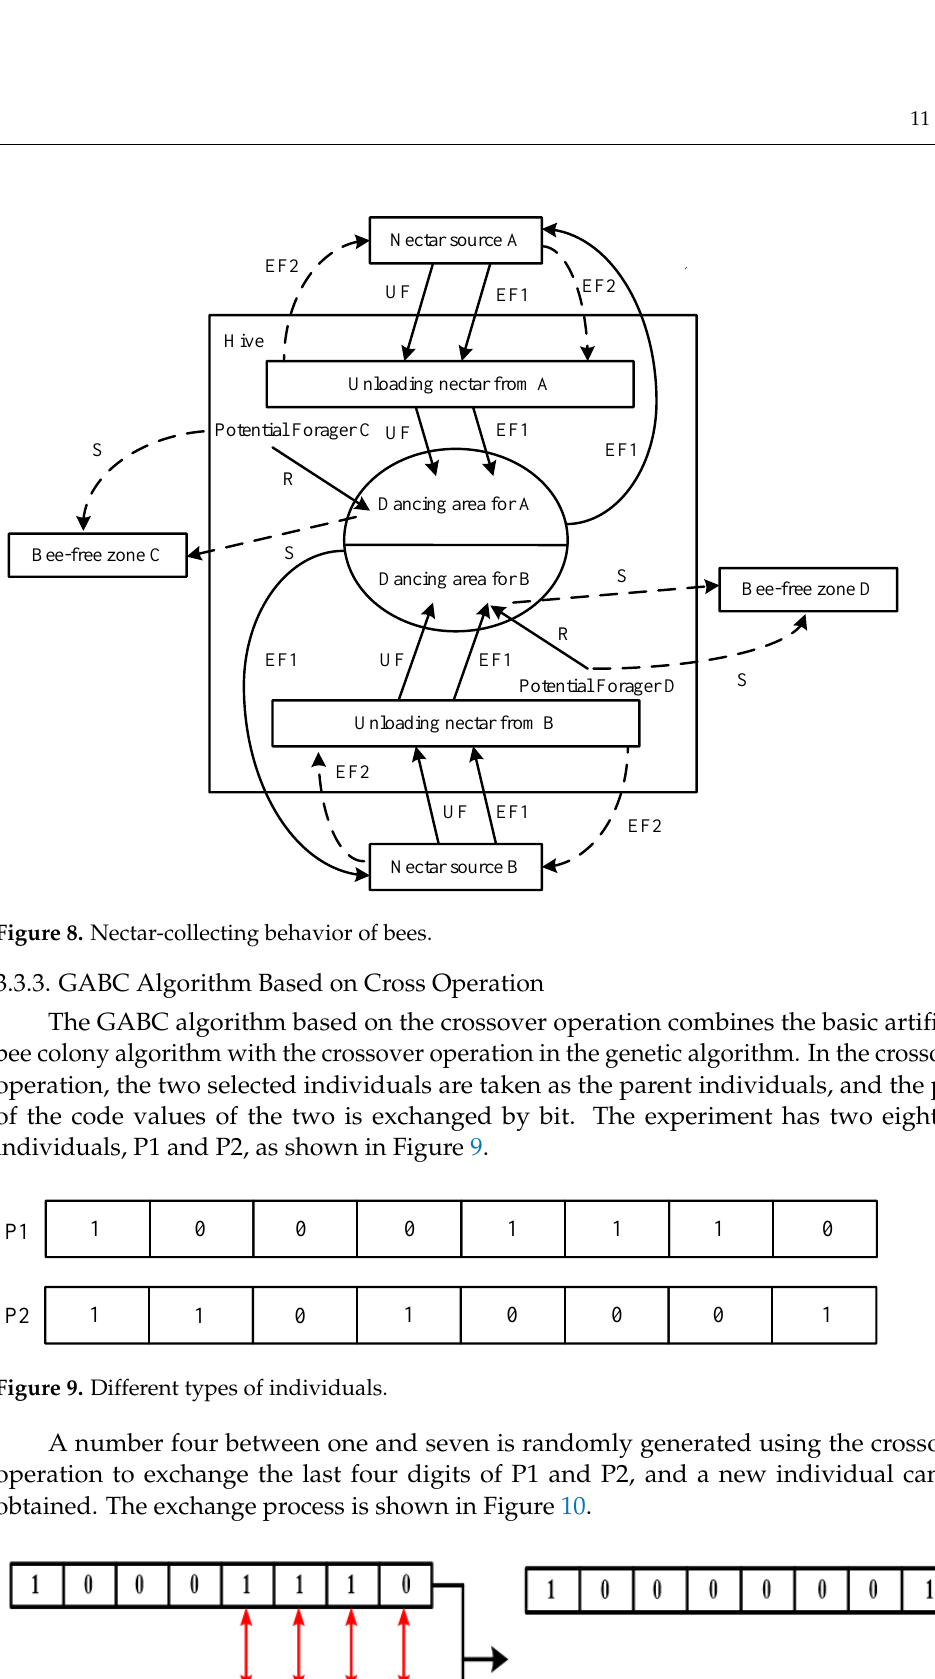
Figure 10. Schematic diagram of crossover operation.